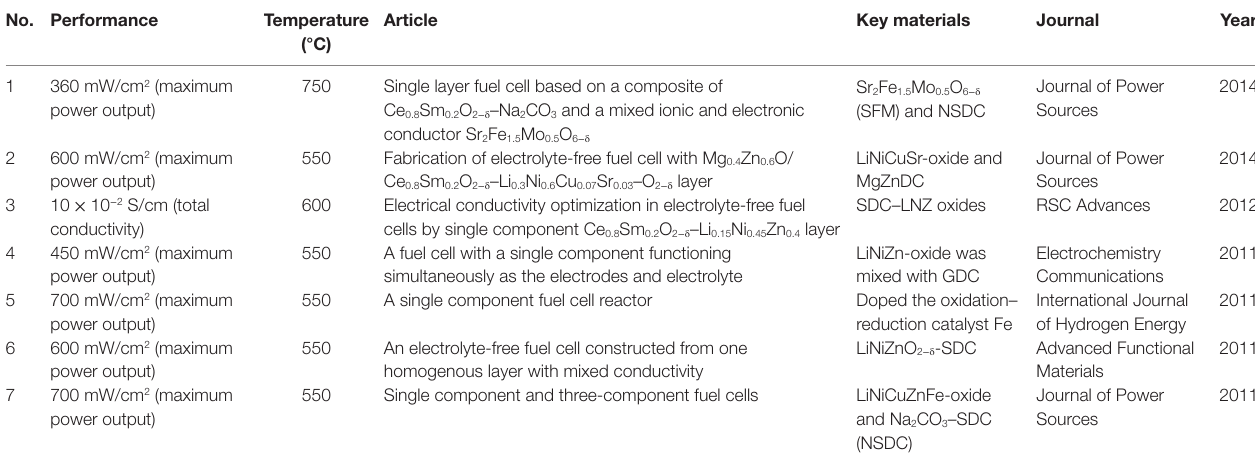
TABLe 1 | Overview of eFFC